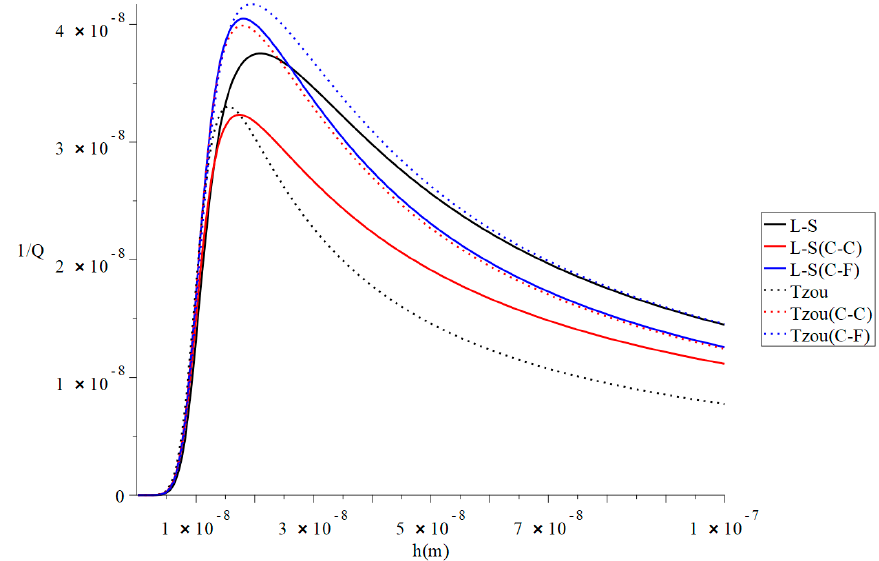
Figure 3. The thermal quality factor is based on the Lord-Shulman (L-S) and Tzou models with various fractional derivative types β = 0.3, L = 50 h , b = 4 h , q = 4.73/ L , and F = 10 − 40